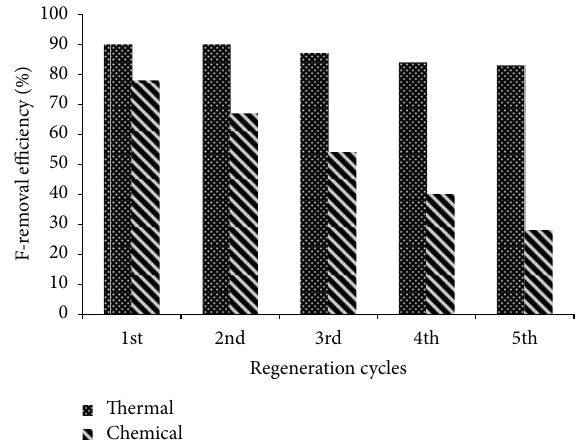
F 8: Regeneration of MIAA by thermal and chemical pro-